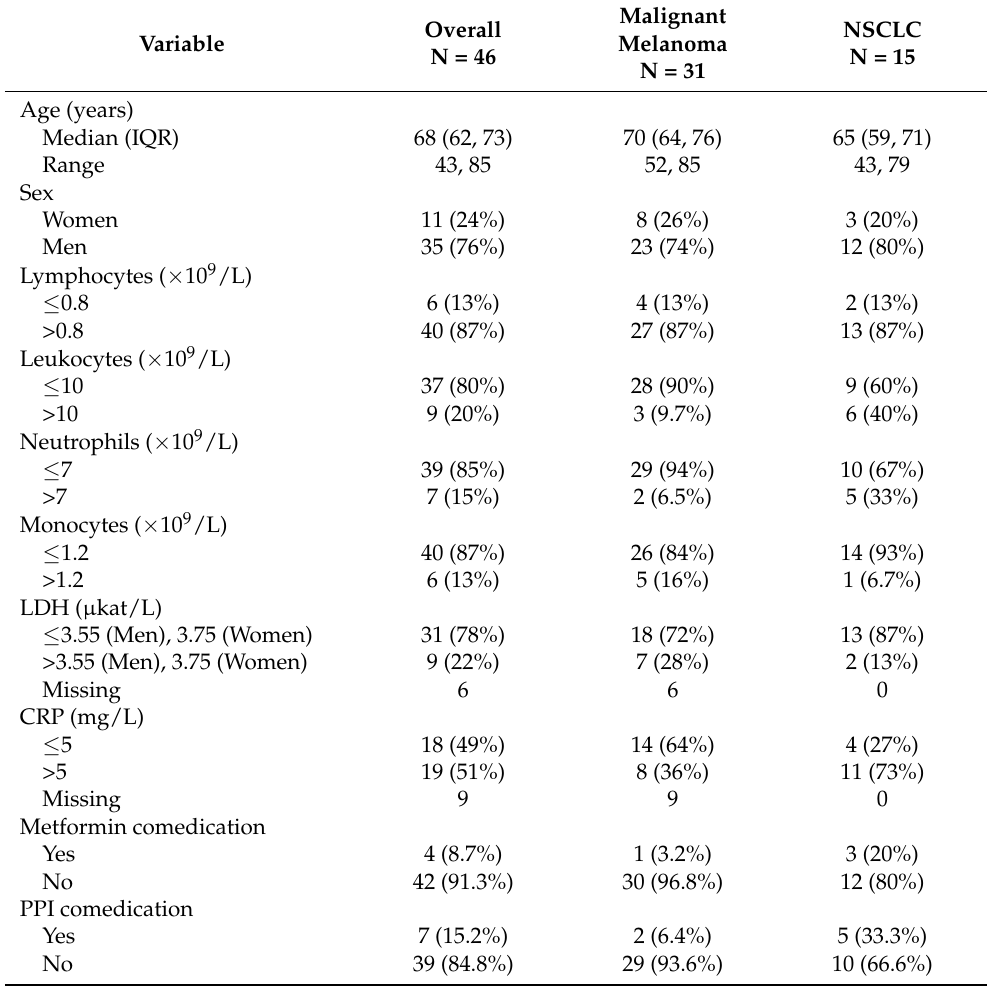
Table 1. Patient